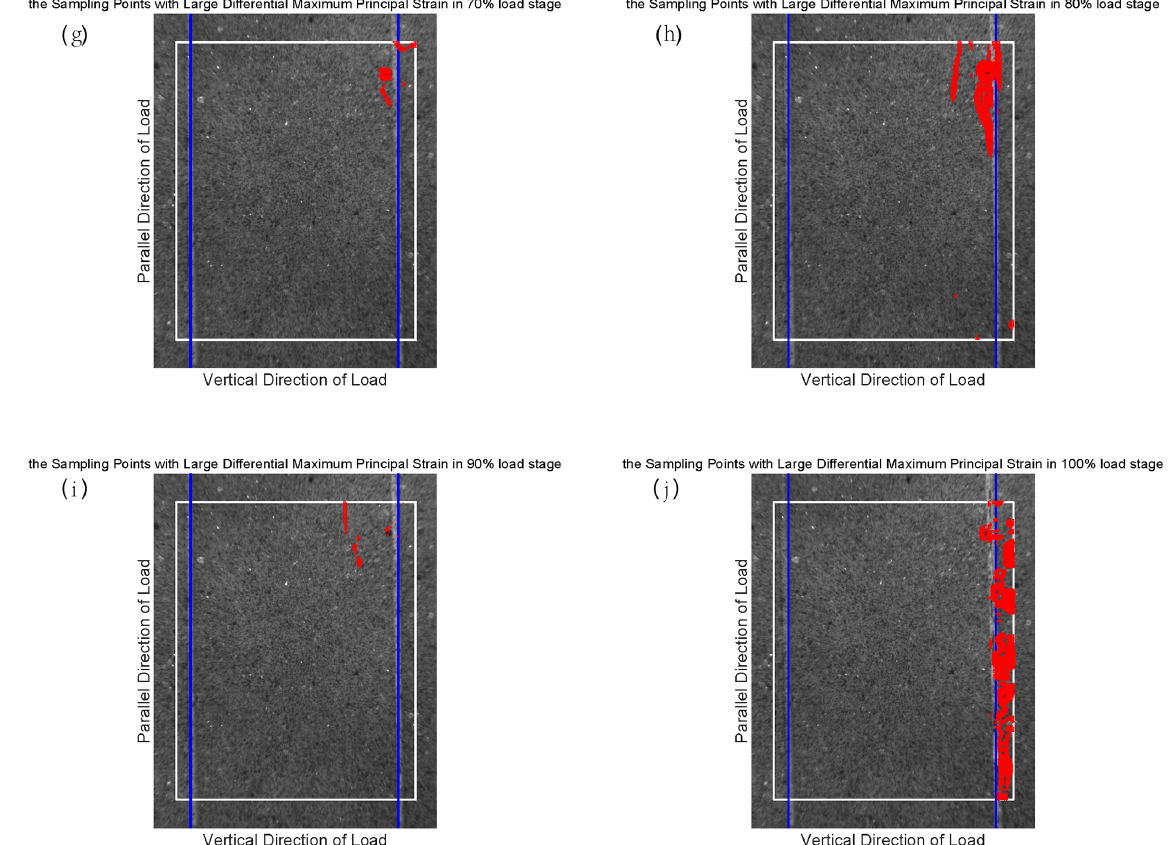
Figure B4. The position of the sampling points with large differential maximum principal strain for sample